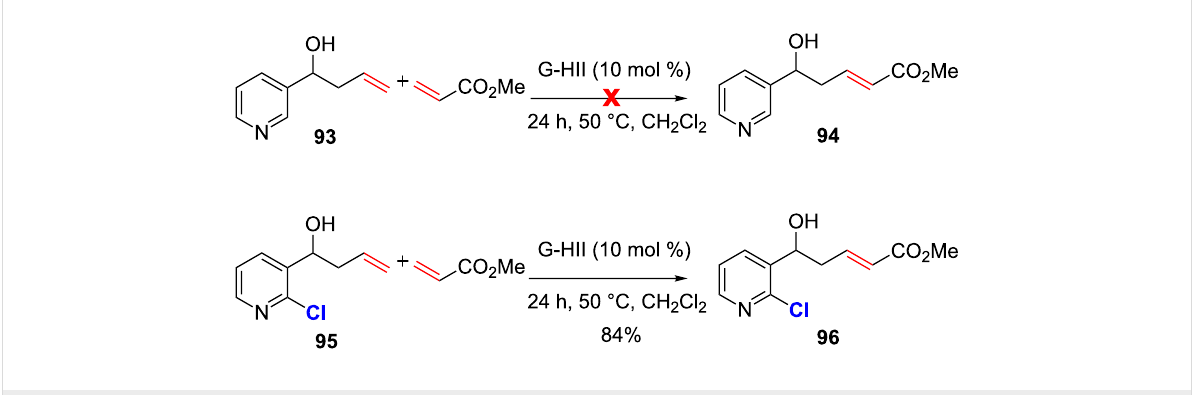
Scheme 35: Successful CM of an alkene containing a 2-chloropyridine.